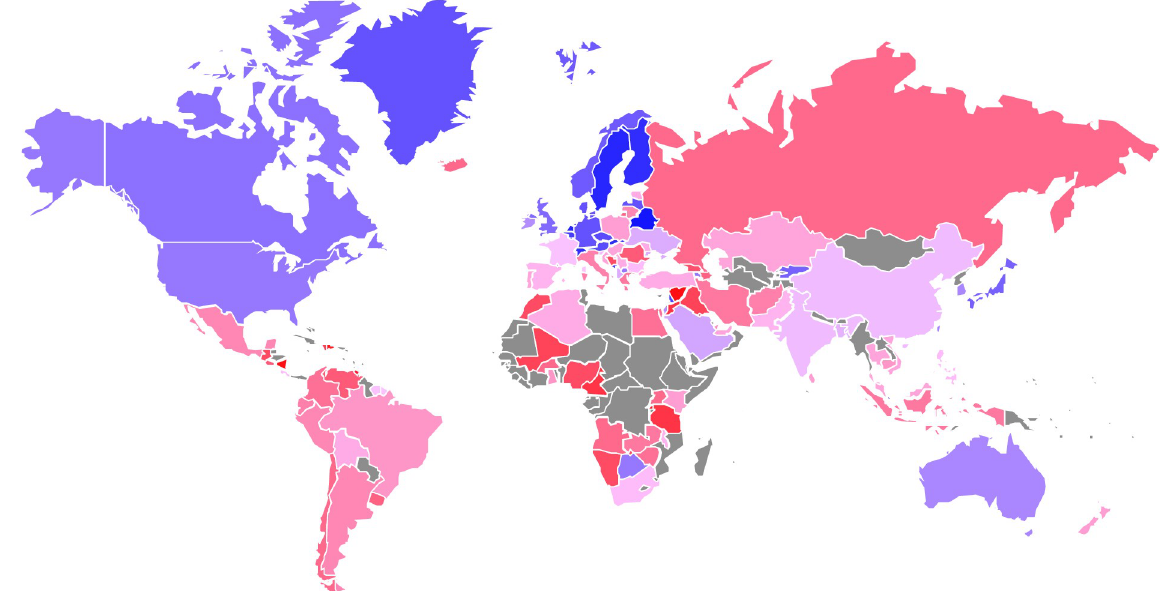
Fig 1. World map of time preferences. Countries with preferences for more immediate rewards are colored in red, countries that emphasize future rewards more are marked in blue, gray colors indicate missing data. Reprinted from https://www.clearlyandsimply.com/clearly_and_ simply/2009/06/choropleth-maps-with-excel.html under a CC BY license, with permission from Robert Mundigl (clearlyandsimply), original copyright 2009.